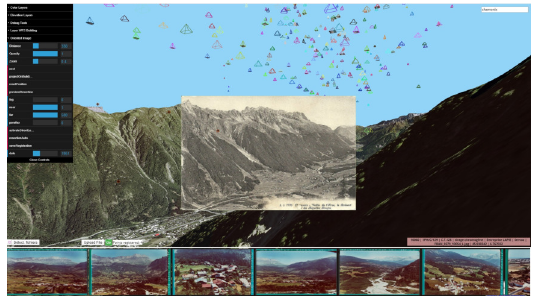
Figure 6. Illustration of the carousel providing the images available as clickable pyramids in the 3D visible environment ( c (cid:13) J. J. 7770 Chamonix - Vall´ee de l’Arve, le Br´event et